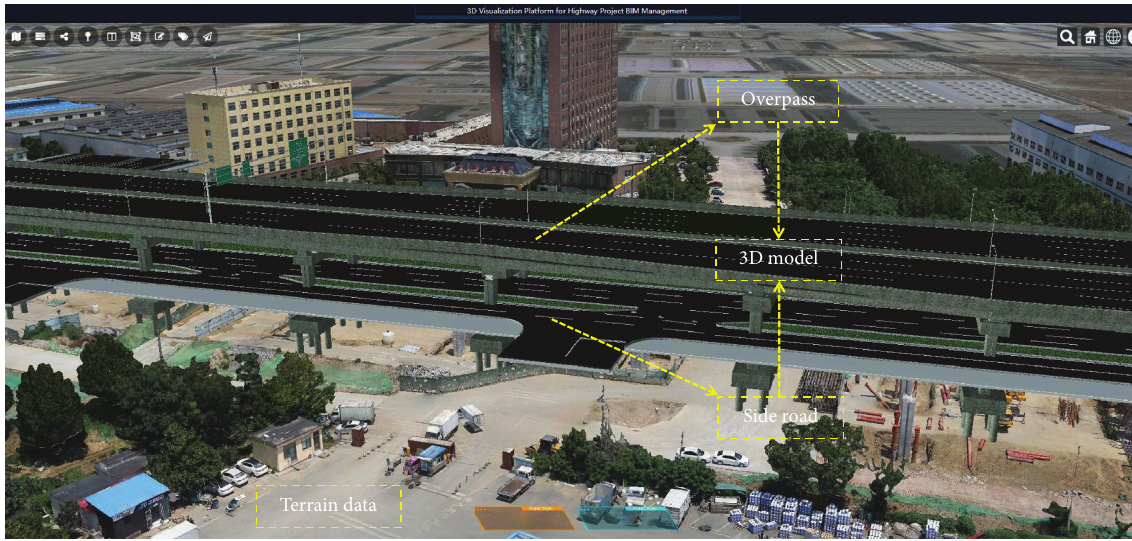
Figure 9: Interface of the BIM